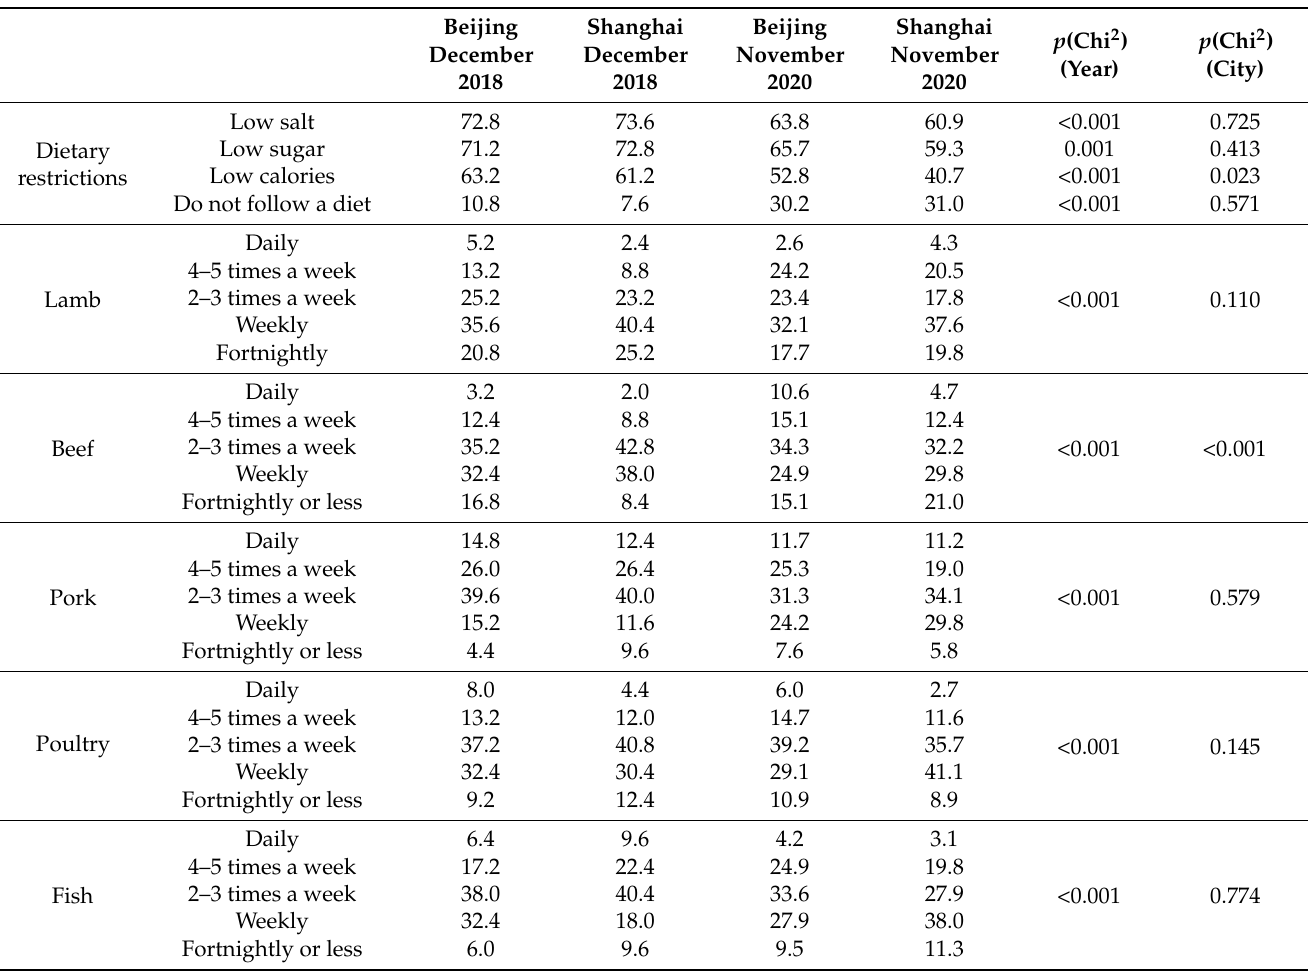
Table 2. Dietary restrictions and consumption frequency of animal protein sources (%) ( p value determined using a Chi-squared test for both year and